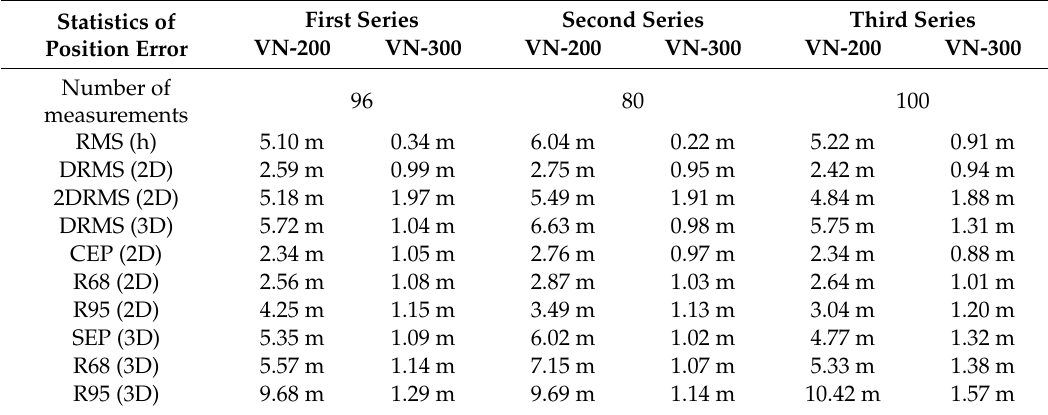
Table 8. Predictable positioning accuracy of VN-200 and VN-300 systems during Inertial Navigation System (INS) measurements in Gdańsk in section no. 3.